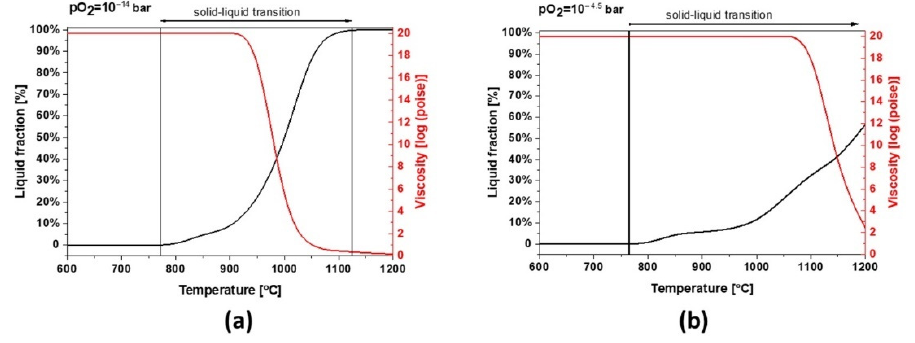
Figure 10. Thermodynamic modeling of the liquid fraction and viscosity for slag 2 ( a ) pO 2 = 1 × 10 − 15 bar and ( b ) pO 2 = 1 × 10 − 4.5 bar.